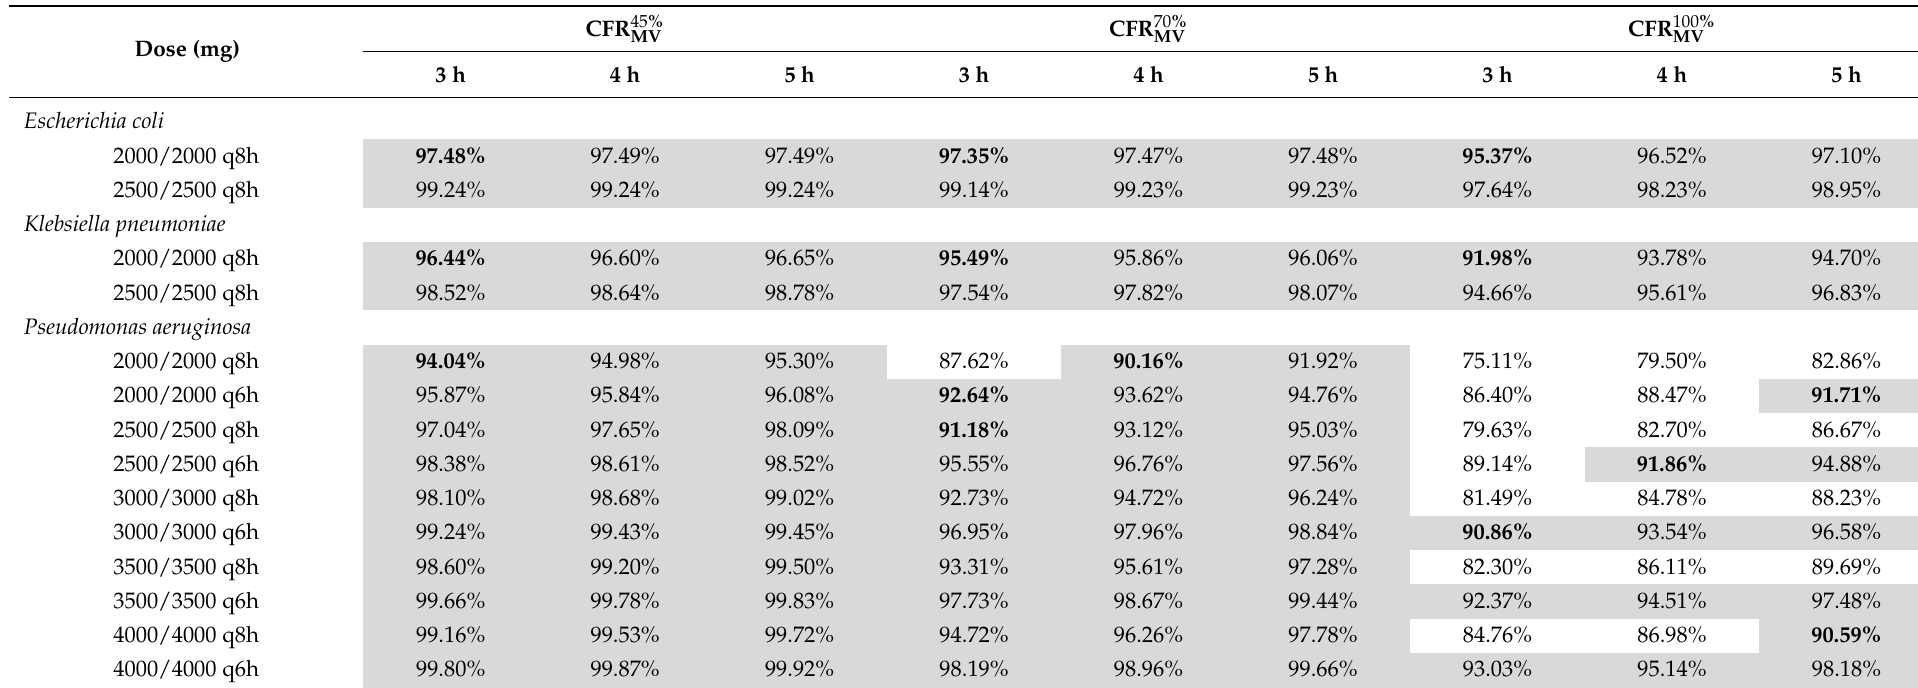
Table 3. Cumulative fraction of responses for meropenem/vaborbactam for Enterobacteriaceae and Pseudomonas